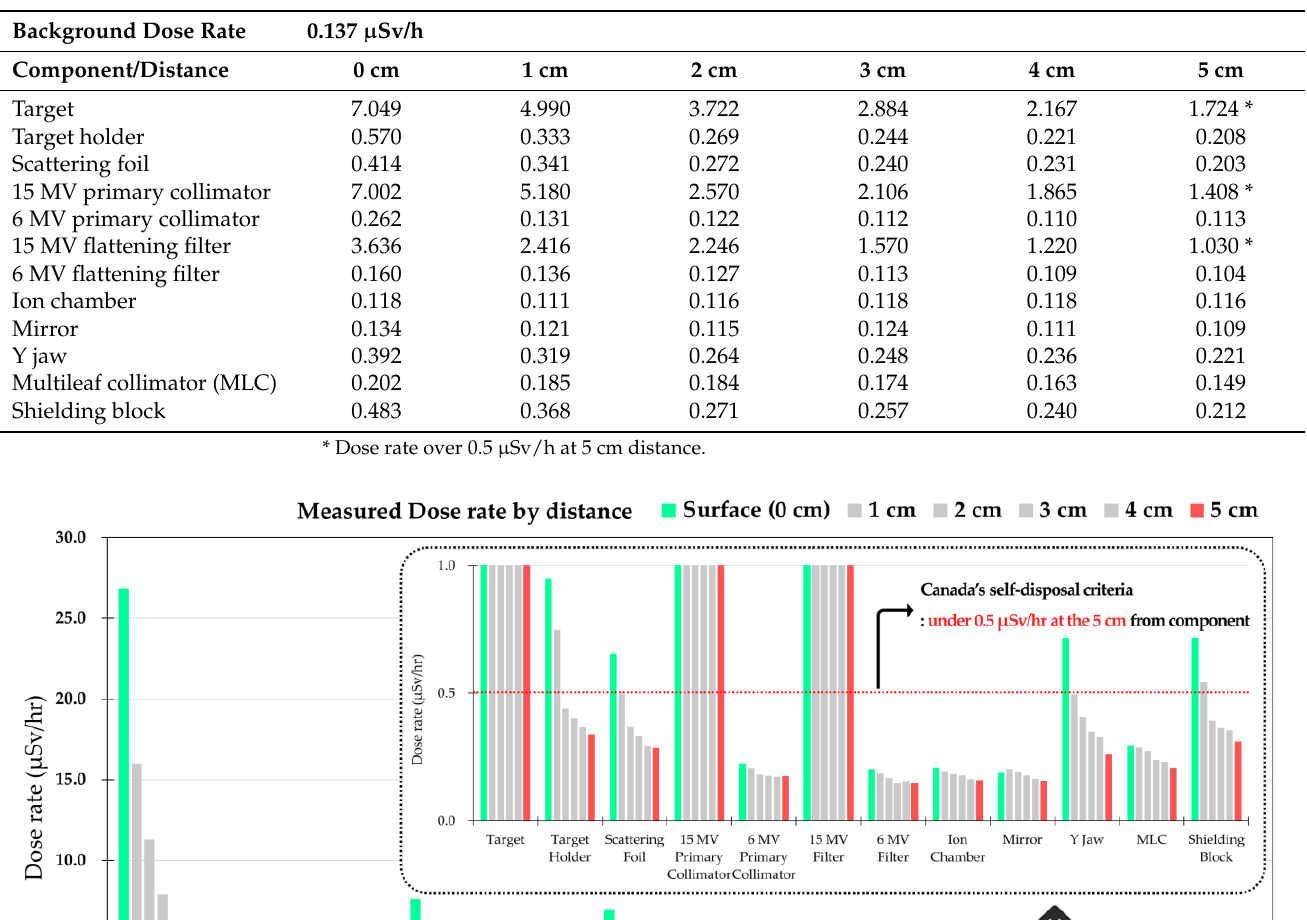
Table 4. Five weeks after disposal: Dose rate according to the distance of components ( µ Sv/h).